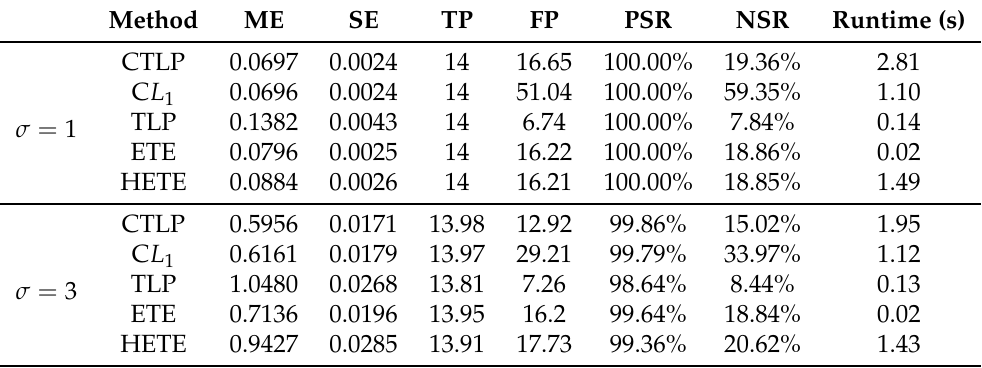
Table 3. The comparison of five methods in the case of n > p , AR ( 1 ) correlation matrix without group structure.